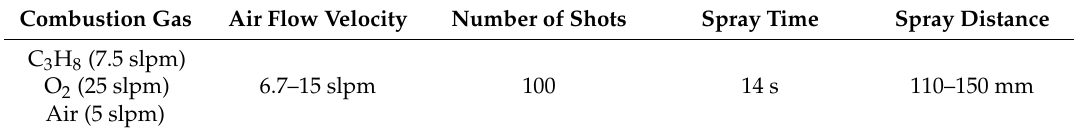
Table 1. Deposition parameters of CoNiCrAlY sprayed using the D-gun technique.